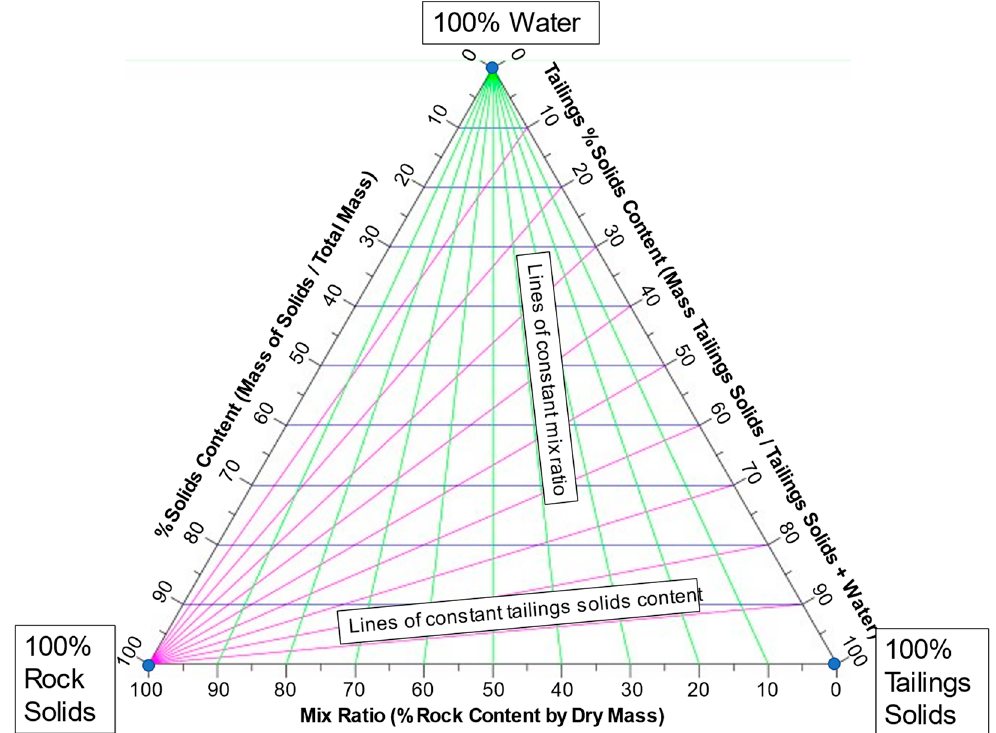
Figure 5. Ternary diagram for waste rock – fine tailings blends.